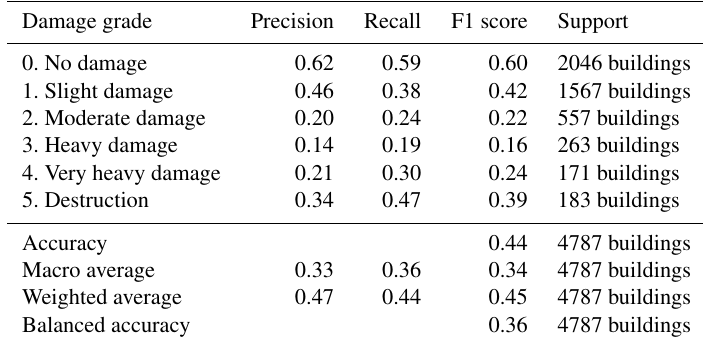
Table 2. Test-set performance metrics for multi-class classification for the 2015 Gorkha